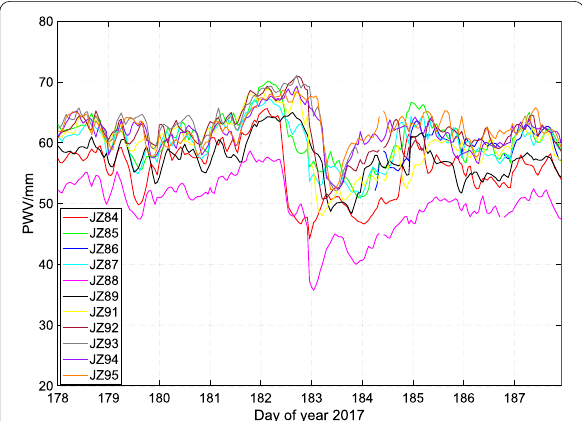
Table 6 Statistical PWV variation after several rainfall events (they are also shown by black circles in Fig. 7) Rainfall events at PWV (mm) Interval corresponding GNSS stations